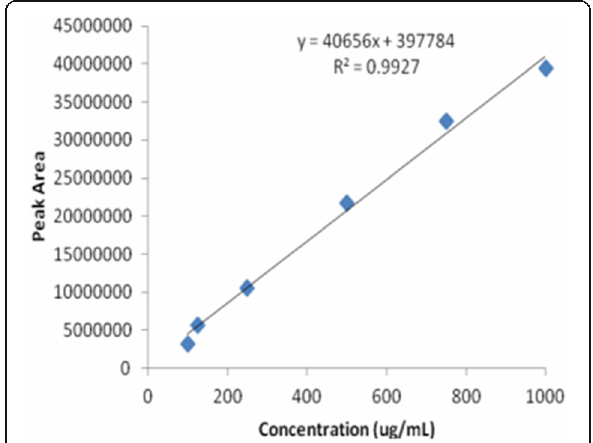
Fig. 4 Calibration curve of sodium glutamate obtained by the proposed HPLC